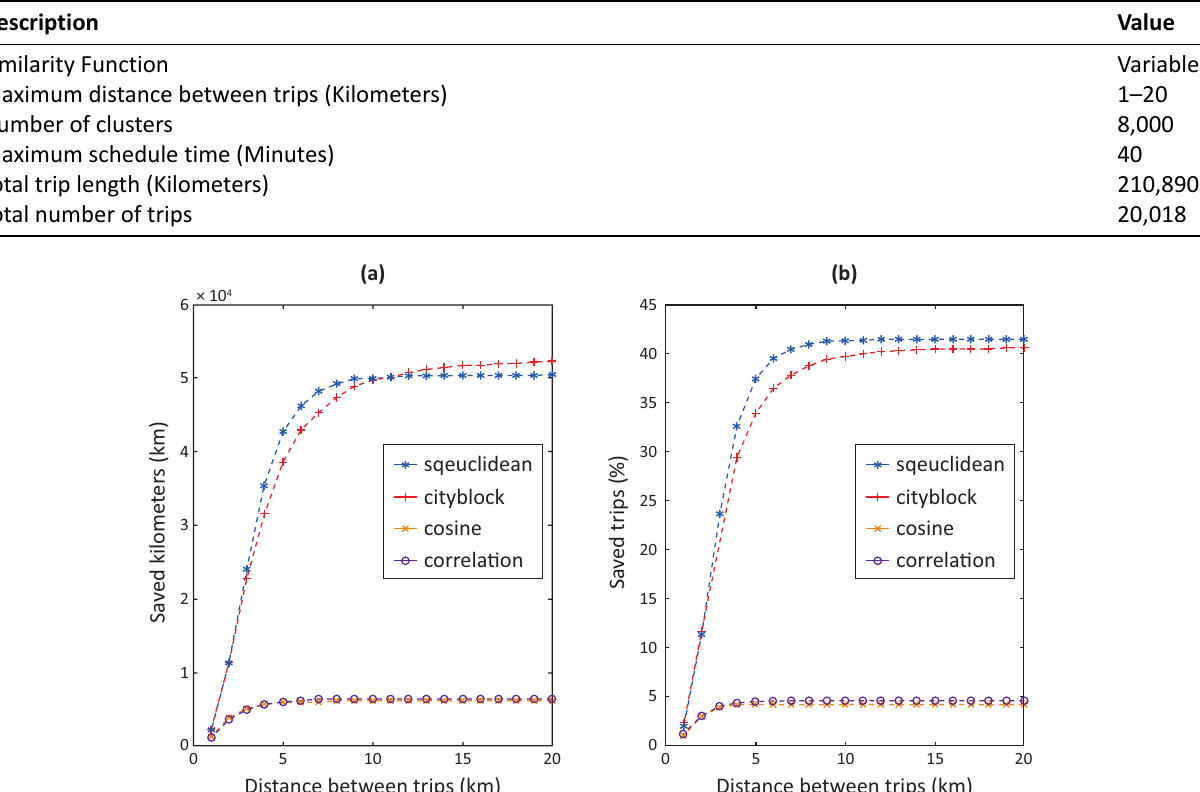
Table 2. Simulation set up parameters (case study 2).